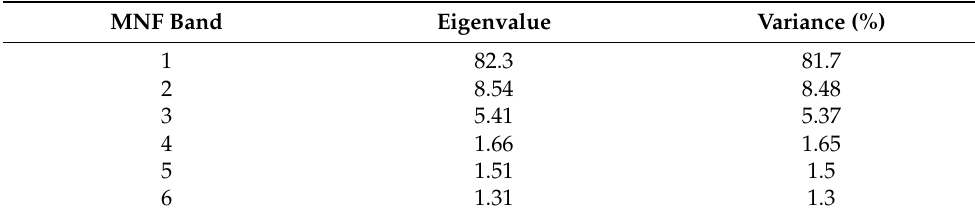
Table 3. Statistical results obtained from MNF